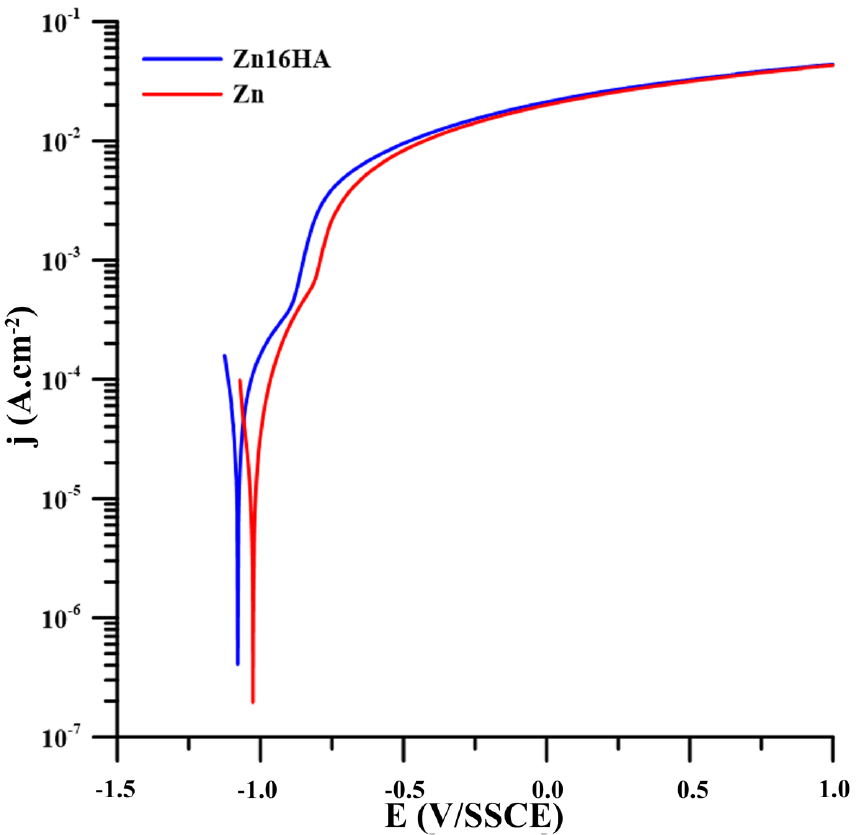
Figure 13. Potentiodynamic measurement of pure Zn and Zn/HA measured in SBF27.